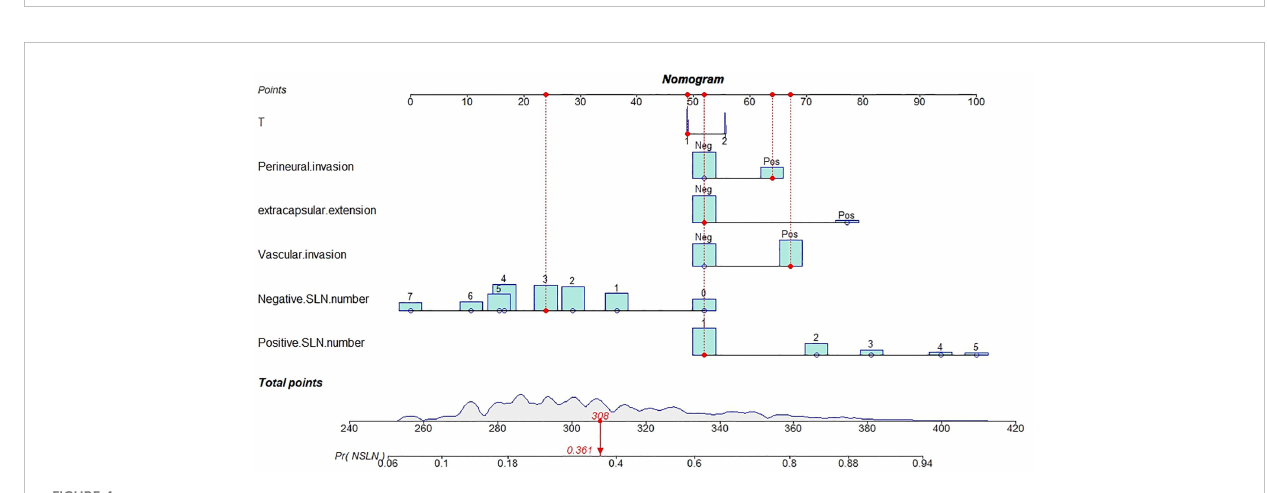
FIGURE 4 Constructed nomogram for predicting the risk of non-SLN metastasis in a